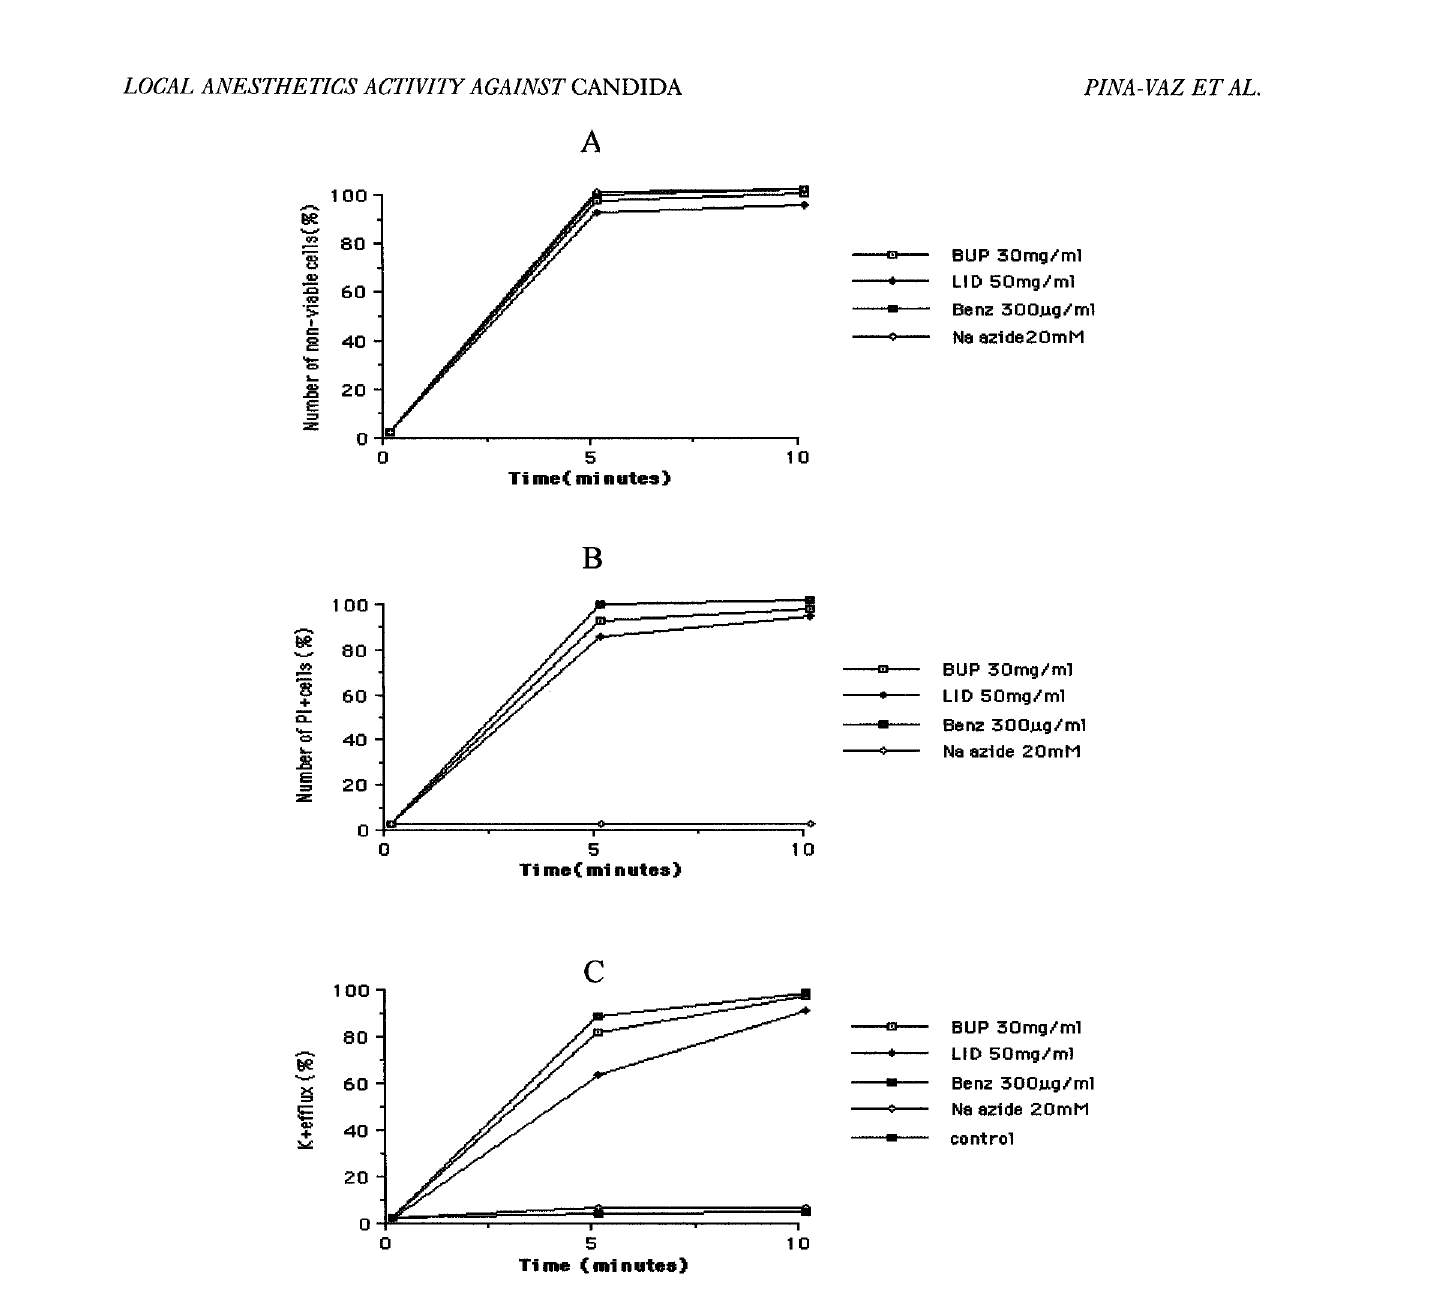
Fig. 4. Exponential phase C. albicans, ATCC strain 10231 cells exposed for I0 min to 0.3 mg/mL of benzydamine (Benz), 50 mg/mL of lidocaine (LID), 30 mg/mL of bupivacaine (BUP) or 20 mM sodium azide (Na azide). In the same suspensions, three parameters were determined, i.e., the percentage of nonviable cells (determined by CFU counts) (A), the percentage of PI-positive cells (B), and K efflux (as percent of the total intracellular K /) (C).